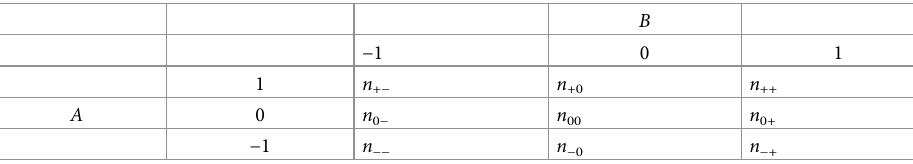
Table 4. Replicability table between methods A and B.